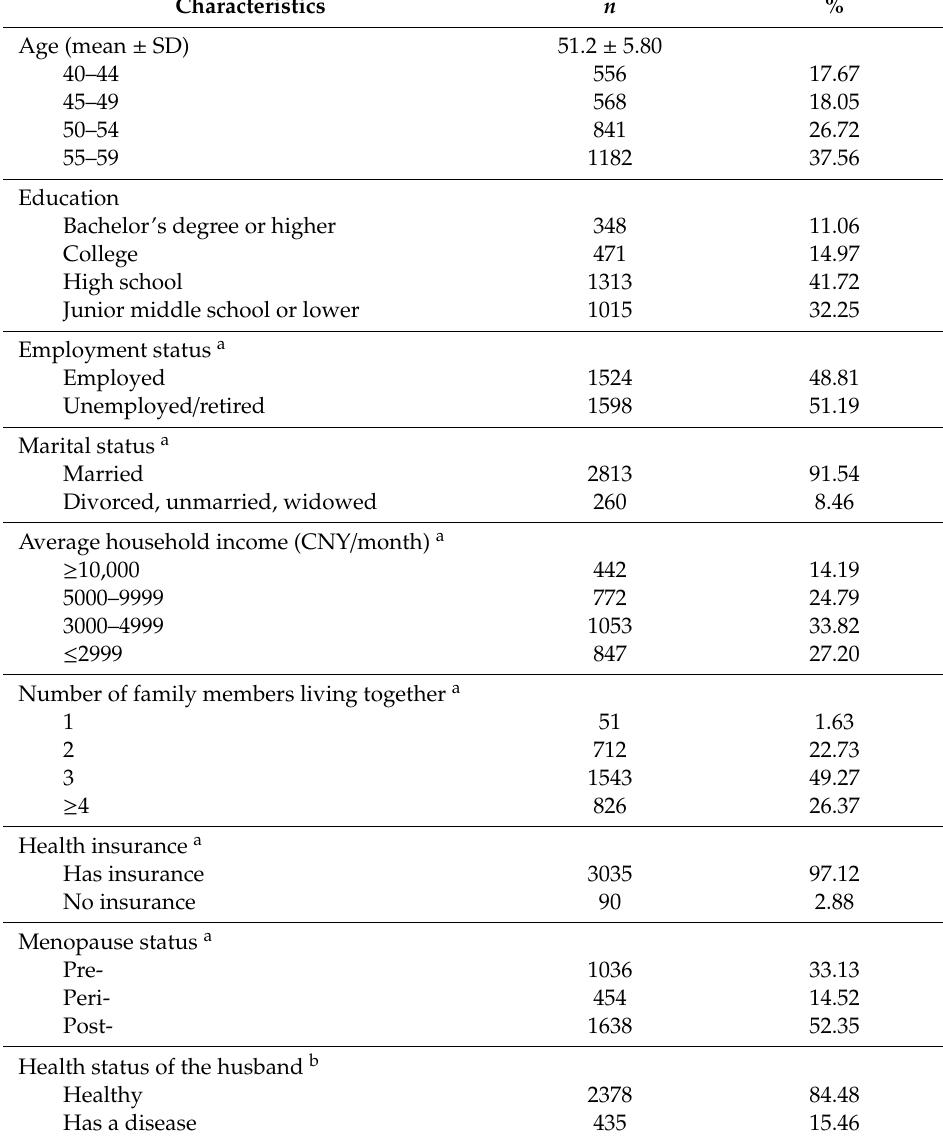
Table 1. General socioeconomic and health characteristics of the study population ( n =